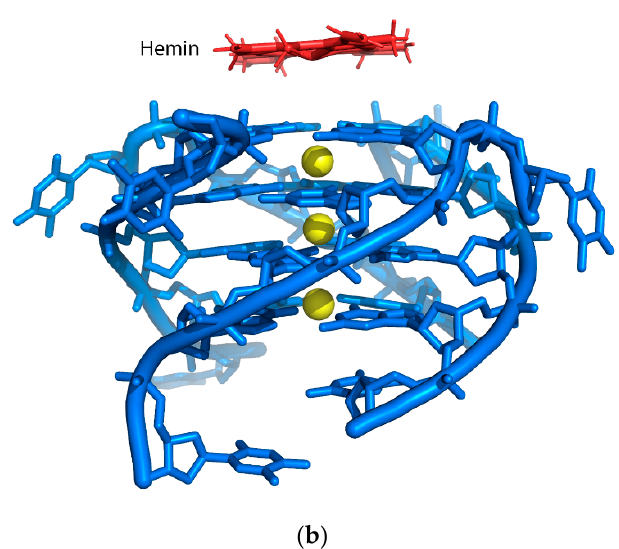
Figure 2. ( a ) Chemical structure of hemin ( b ) G-quadruplex-hemin complex.